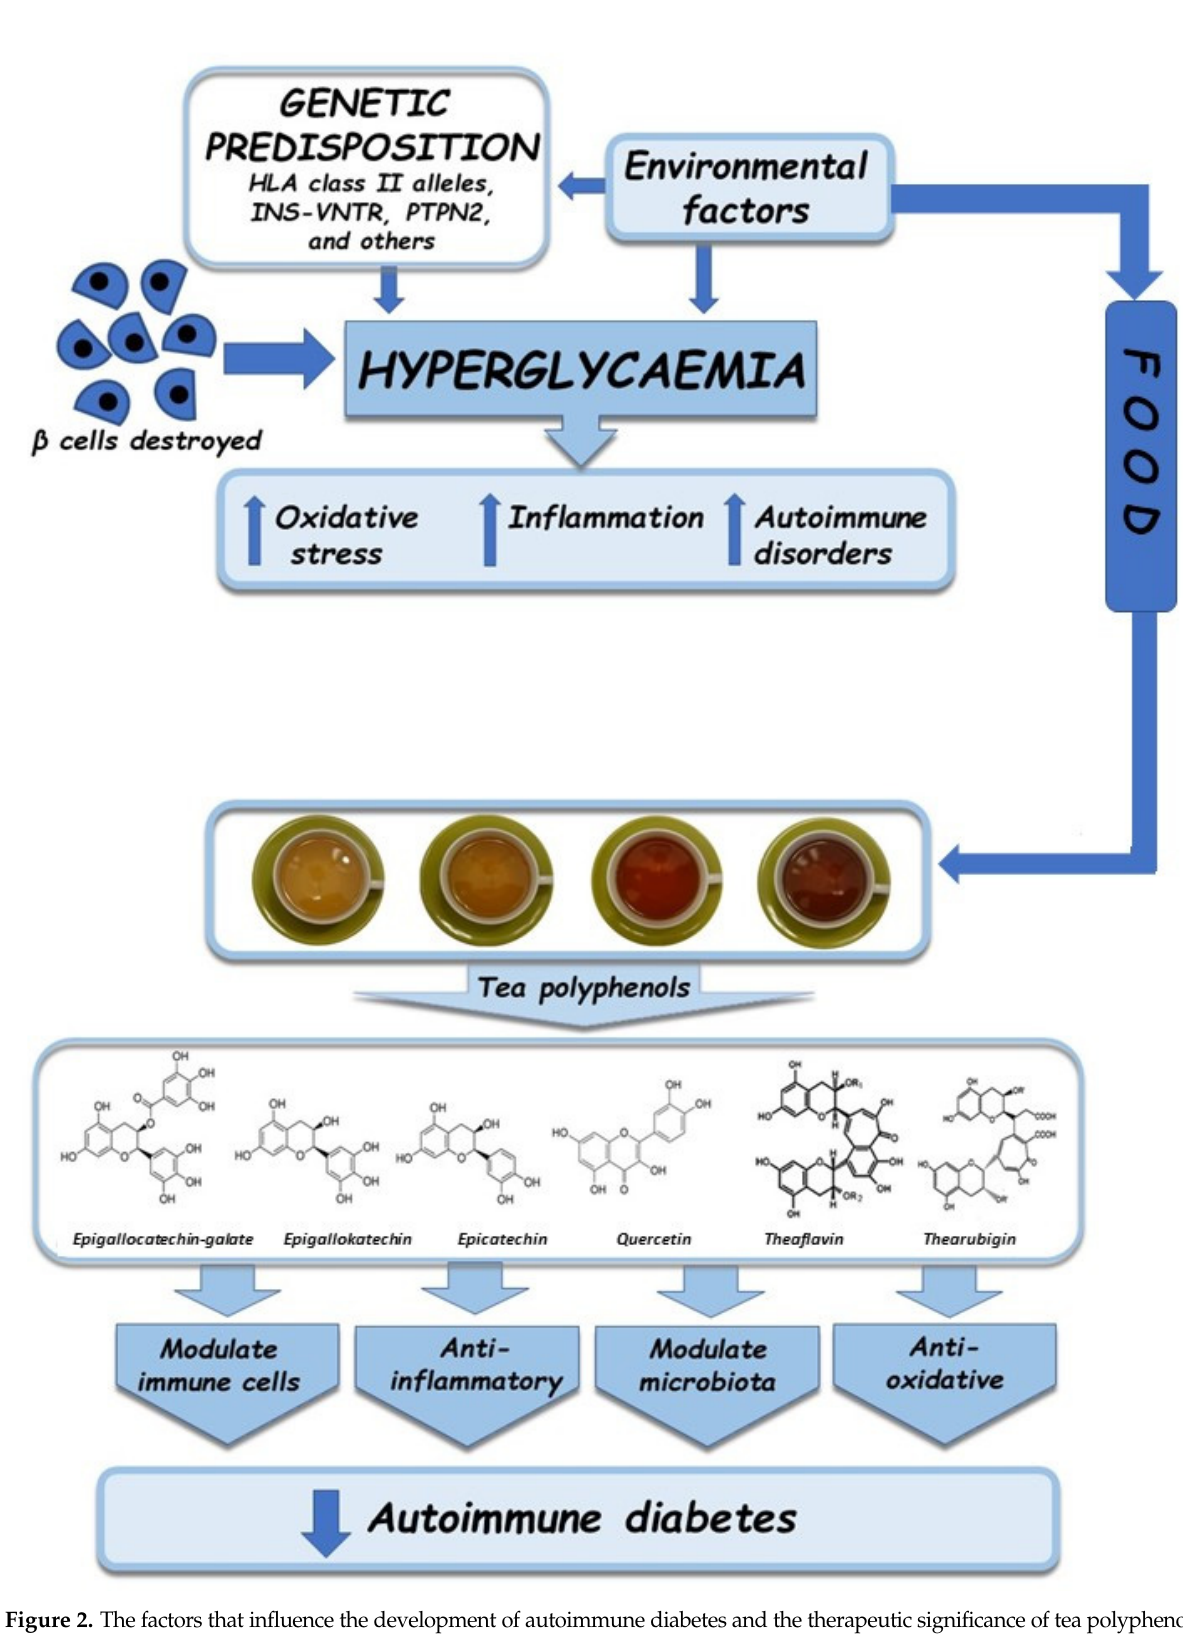
Figure 2. The factors that influence the development of autoimmune diabetes and the therapeutic significance of tea pol- yphenols.